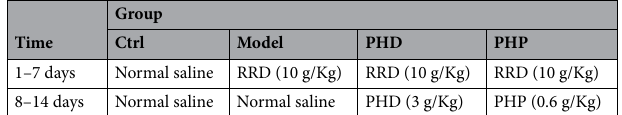
Table 1. Experimental plan and treatment procedure.